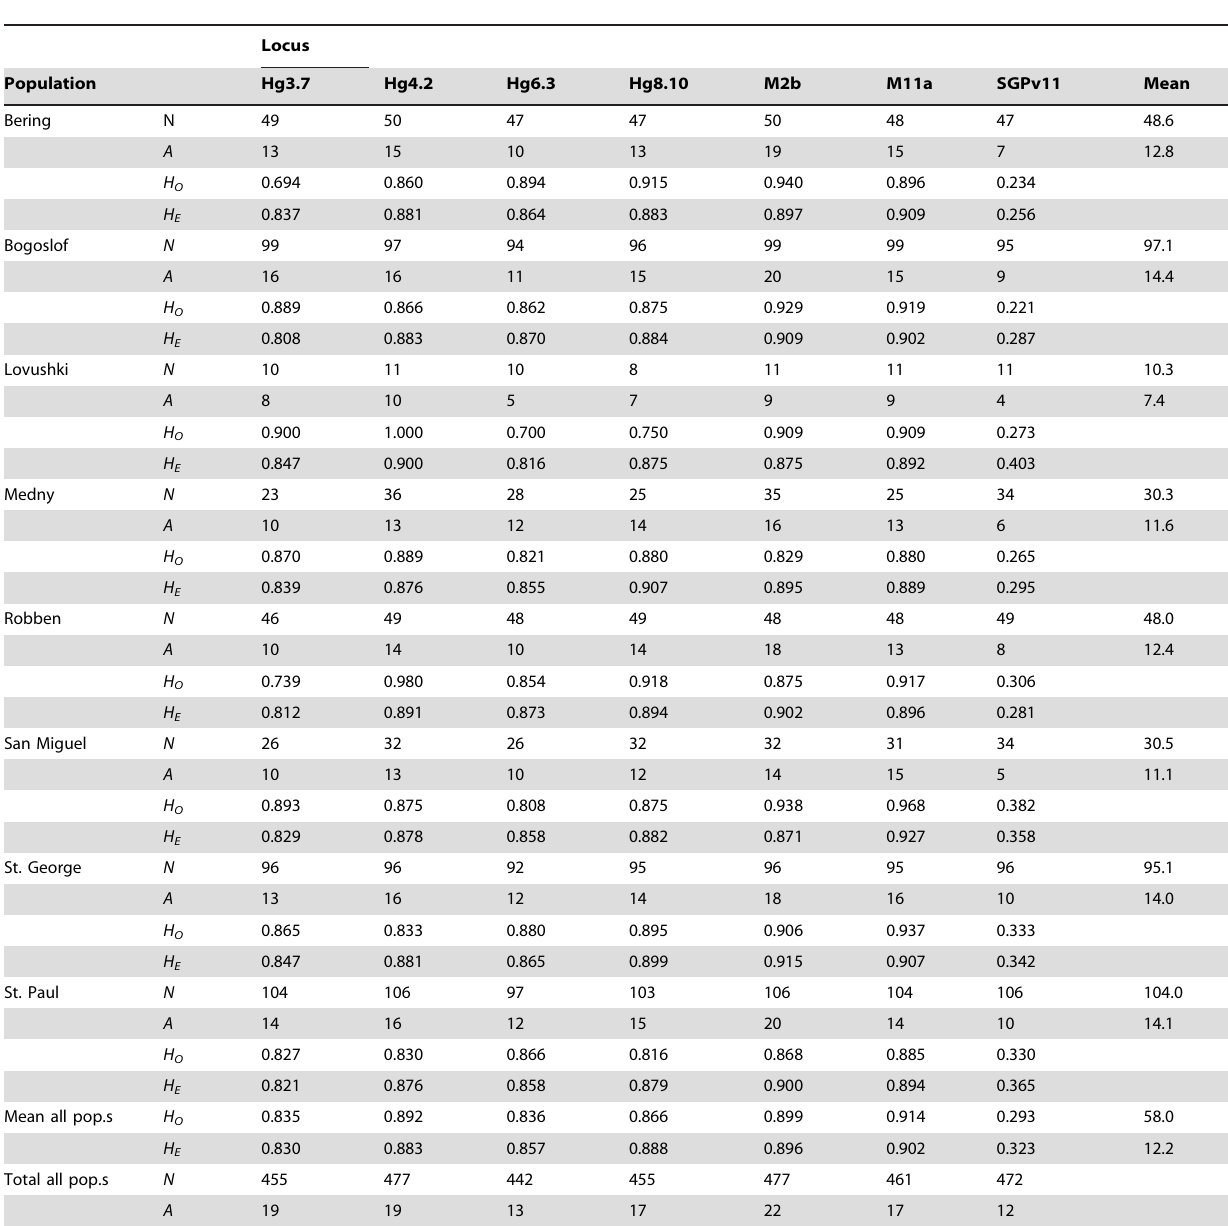
Table 1. Summary of allelic variability at seven microsatellite loci in eight populations of northern fur